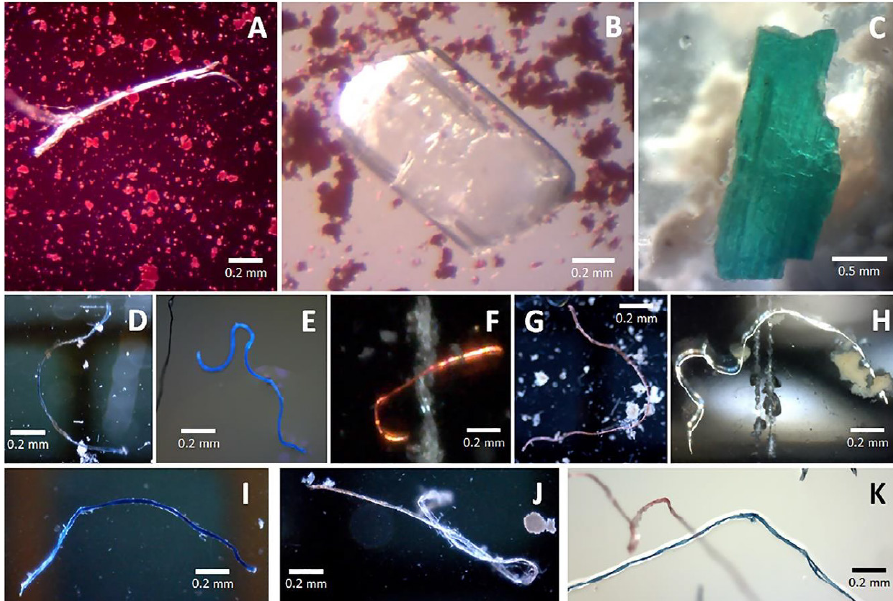
Fig. 2: Microplastics ingested by S. lemuru . (A-B) Microplastic and stomach content stained with 1% Rose Bengal. Microplastics isolated from the stomach of sardines were classified into (A, D-K) fibers, (B) fragments, and (C) films